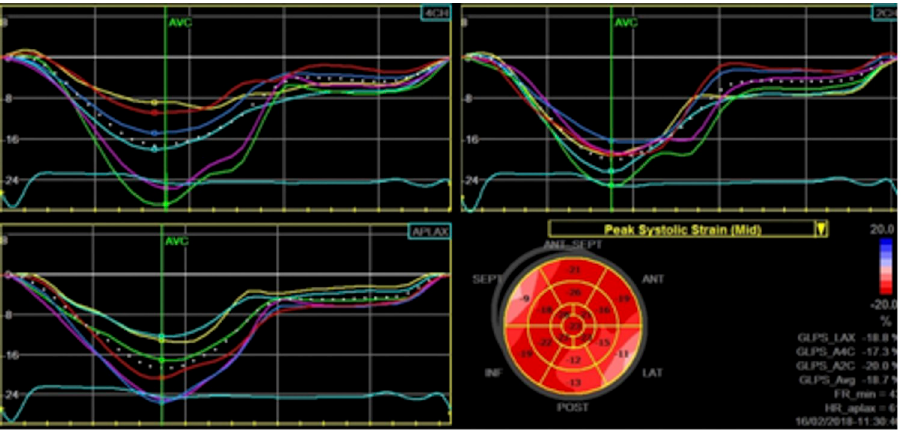
Fig 2. Left ventricular strain curves and bull’s eye plots. LV longitudinal strain curves derived from speckle-tracking analysis for each LV segment at apical 4-chamber view (left panel), paraesternal long-axis view (left lower panel), 2-chamber view (right upper panel), and bull’s eye” plot (right lower